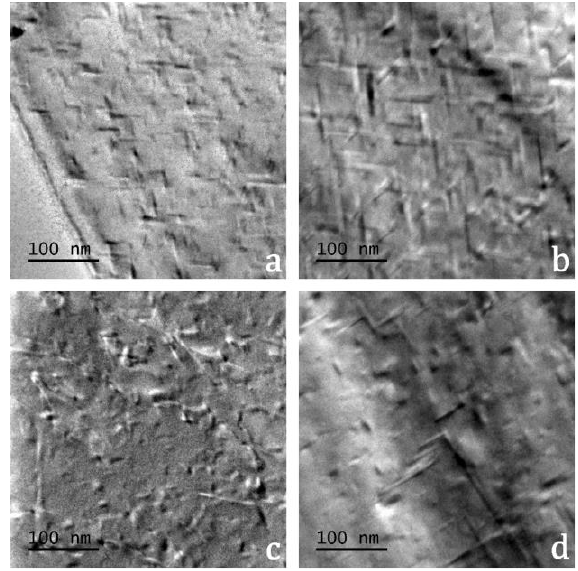
Figure 5. Transmission electron microscopy (TEM) images showing roughly peak-aged (10.8 h at 175 °C) nanostructures in the high strength Si-rich ( a , b ) and Mg-rich ( c , d ) alloys with 0.5 h prior NA (a,c) and 4 h prior NA (b,d).